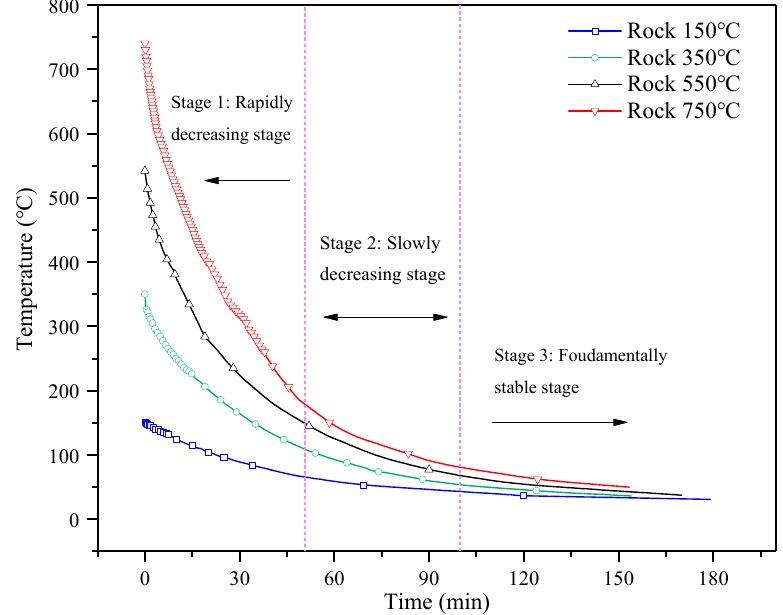
Figure 4. The cooling and heating rates for different targeted temperature granite samples: ( a ) cooling rate and ( b ) heating rate.